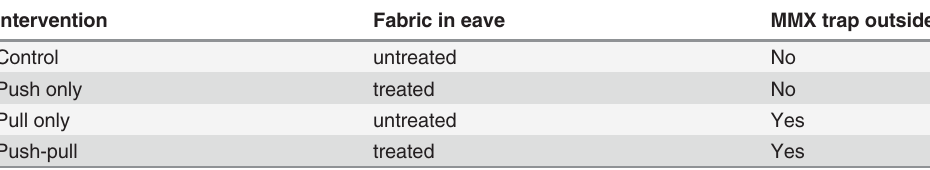
Table 4. Overview of which push and pull elements were present during the various